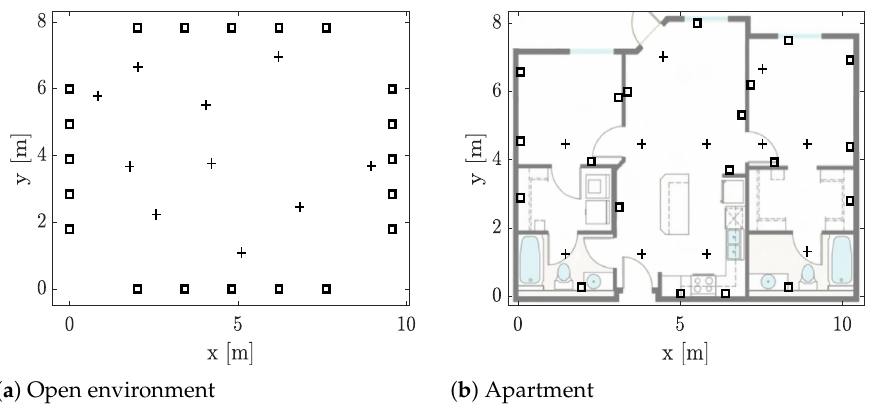
Figure 5. The experimental layouts in which the nodes ( ) and the reference positions ( ) are illustrated [3], reprinted with permission from ref. [3]. Copyright 2019